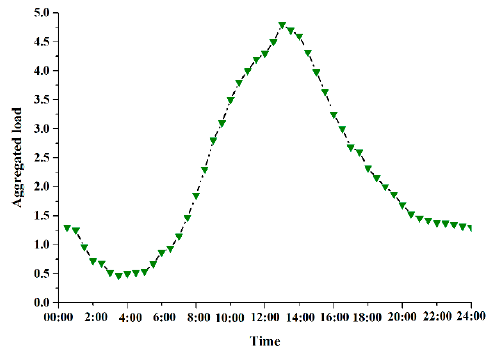
ffi c variation during an operational day Figure 2. Traffic variation during an operational day [55]. Figure 2. Tra